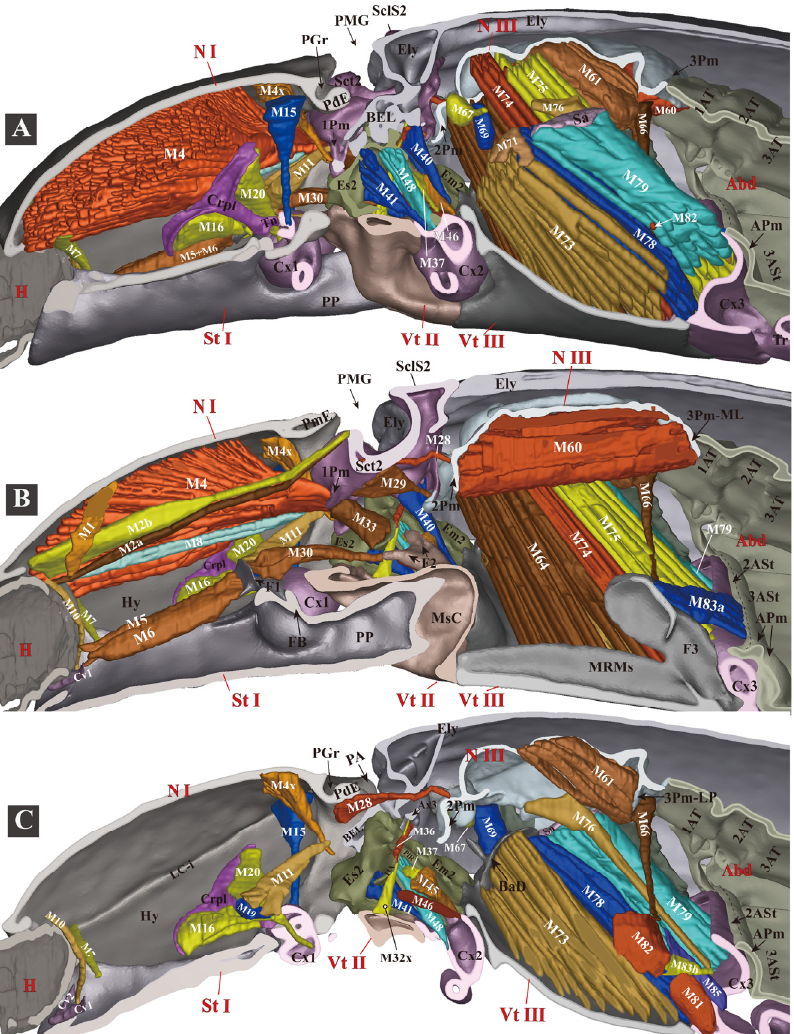
Figure 7. Three-dimensional reconstructions of the thoracic skeleton and musculature of Campsoster- nus auratus , lateral view. The model’s head is facing left; the exoskeleton is cut along the parasagittal and sagittal planes, to show the internal muscles. See Section 2 ‘Materials and Methods’ for technical information and abbreviations. ( A ) model is cut along the left 1/3 in the parasagittal plane. ( B ) model is cut in the sagittal plane, muscles on the left 1/2 of the body are hidden. ( C ) model is cut along the right 1/3 in the parasagittal plane, muscles on the left 2/3 of body are